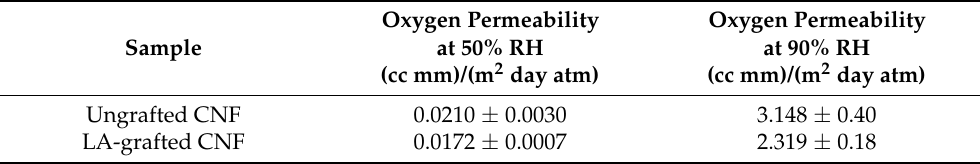
Table 6. Oxygen permeability of CNF and lactic-acid grafted CNF